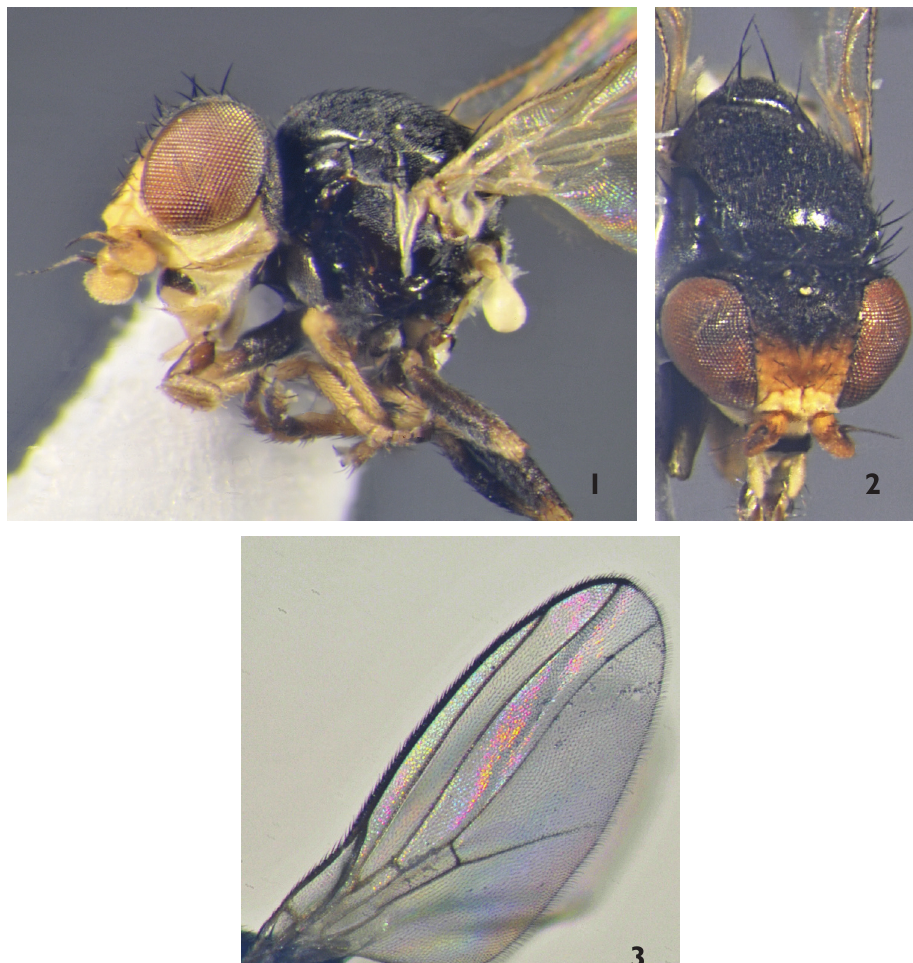
Figure 1–3. Dicraeus civeleki sp. n. (holotype): 1 body (abdomen missing), lateral view 2 body (abdo- men missing), dorsal view 3 wing.